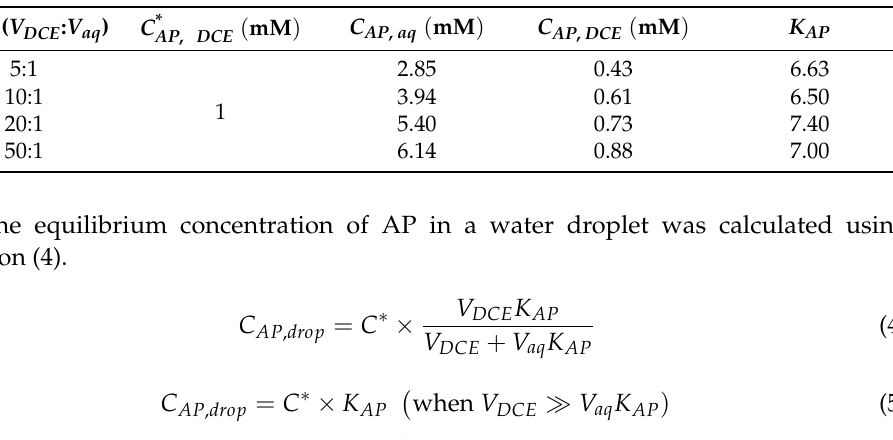
Table 1. Electrochemically obtained equilibrium constant ( K AP ) of